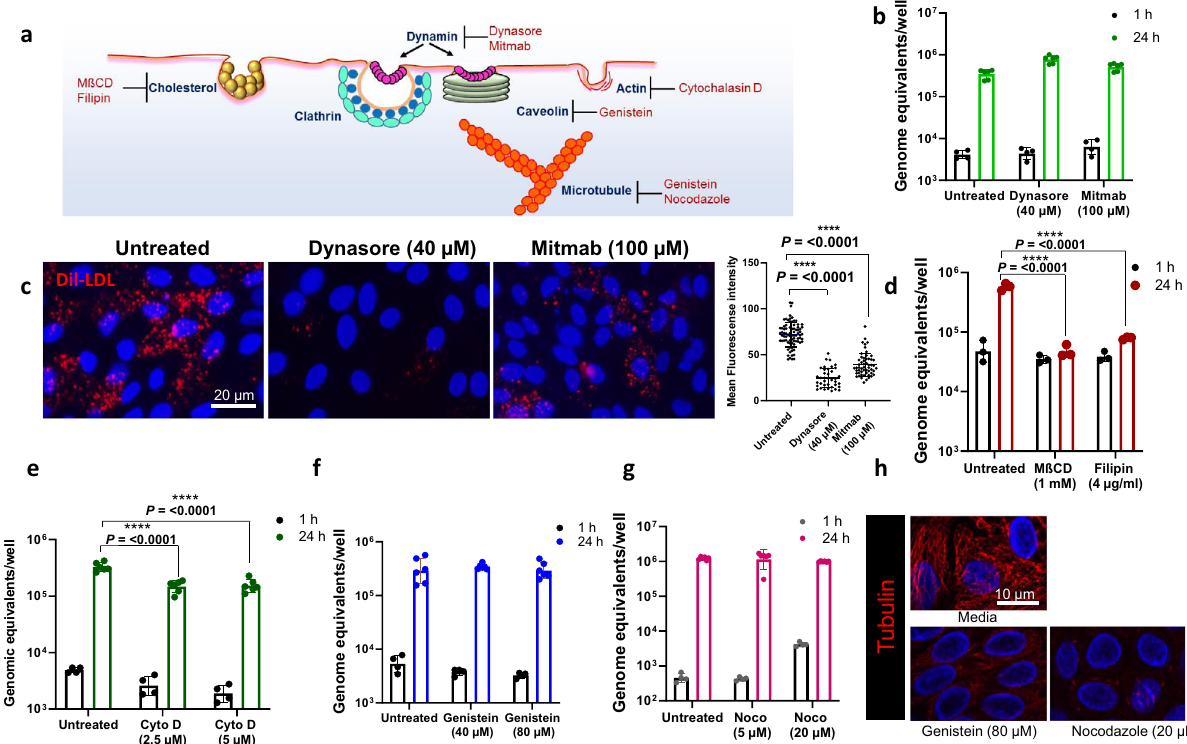
Fig. 2 | GII.4 entry is dynamin-independent but depends on cholesterol and actinforinfection.a Schematicofmajorendocytosispathways,keyregulatorsand their inhibitors. b GII.4 replication (at 37 o C) was assessed in the presence of dynamininhibitors,dynasoreandmitmab.ViralRNAreplicationwasquanti fi edat1 (black) and 24h (green) by RT-qPCR. c Validation of dynamin inhibitor activity by Dil-complexed low density lipoprotein (Dil-LDL) uptake (red). Right panel: Quan- titation of Dil-LDL uptake in untreated (80 ROI), dynasore-treated (38 ROI) and mitmab-treated (55 ROI) HIEs. d GII.4 replication in the presence of cholesterol sequestrants, MßCD and fi lipin, at 1h (black) and 24h (red) at 37 o C. e GII.4 repli- cationinthe presenceof actindepolymerizingagent cytochalasinD (Cyto D)at1h (black) and 24h (green). f GII.4 replication in the presence of receptor tyrosine